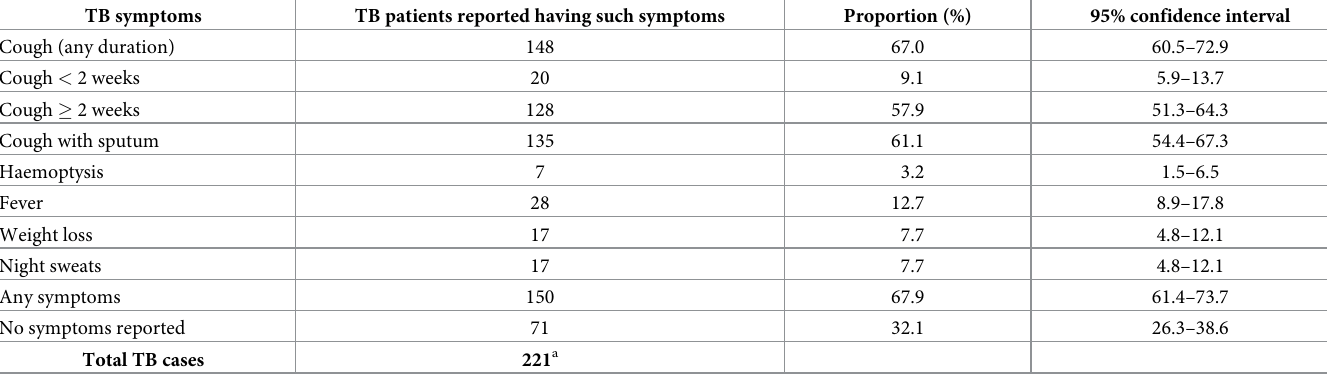
Table 3. TB symptoms reported by bacteriologically confirmed TB cases in the in-depth interview. TB symptoms TB patients reported having such